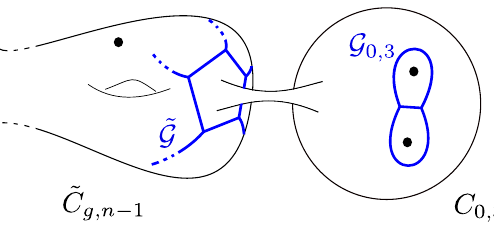
Figure 20. When C has two punctures, we can always choose a pairs-of-pants decomposition featuring a trinion glued to the rest of C along a single puncture. The critical graph of the Strebel di(cid:11)erential respecting the pants decomposition is shown in